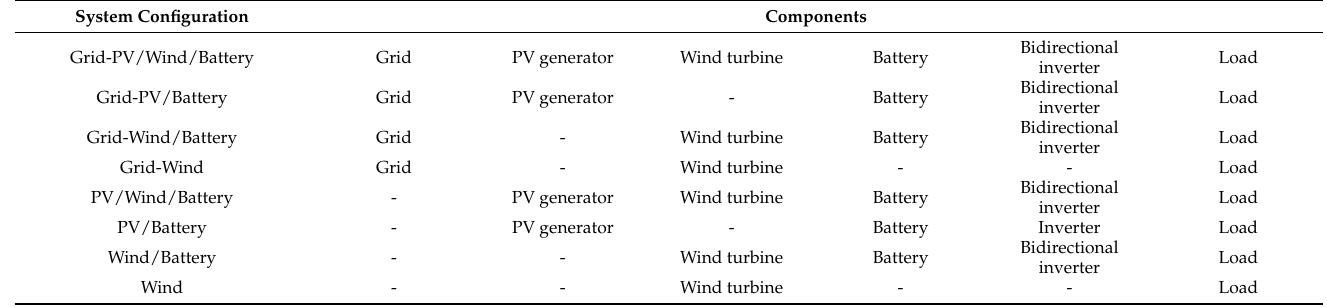
Table 1. System configurations with their different components.